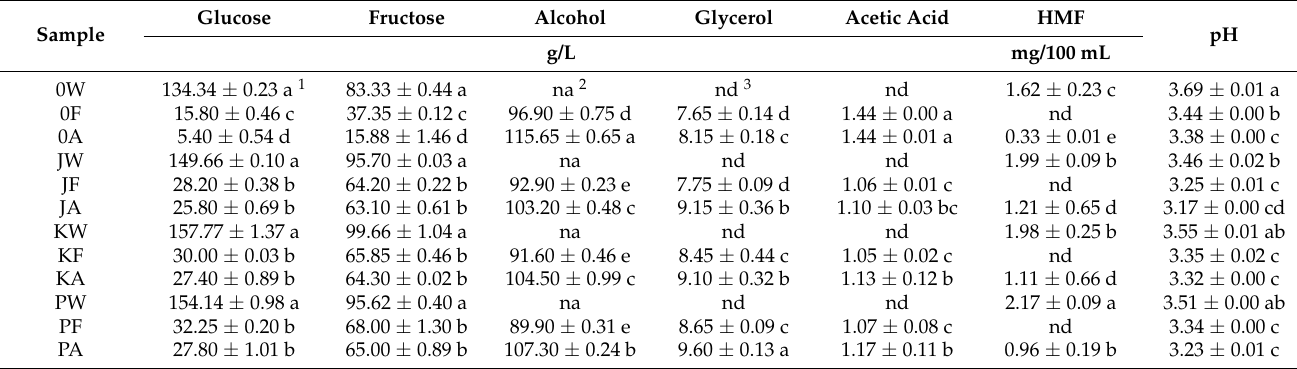
Table 1. Basic physicochemical parameters of classic and Cornelian cherry meads.